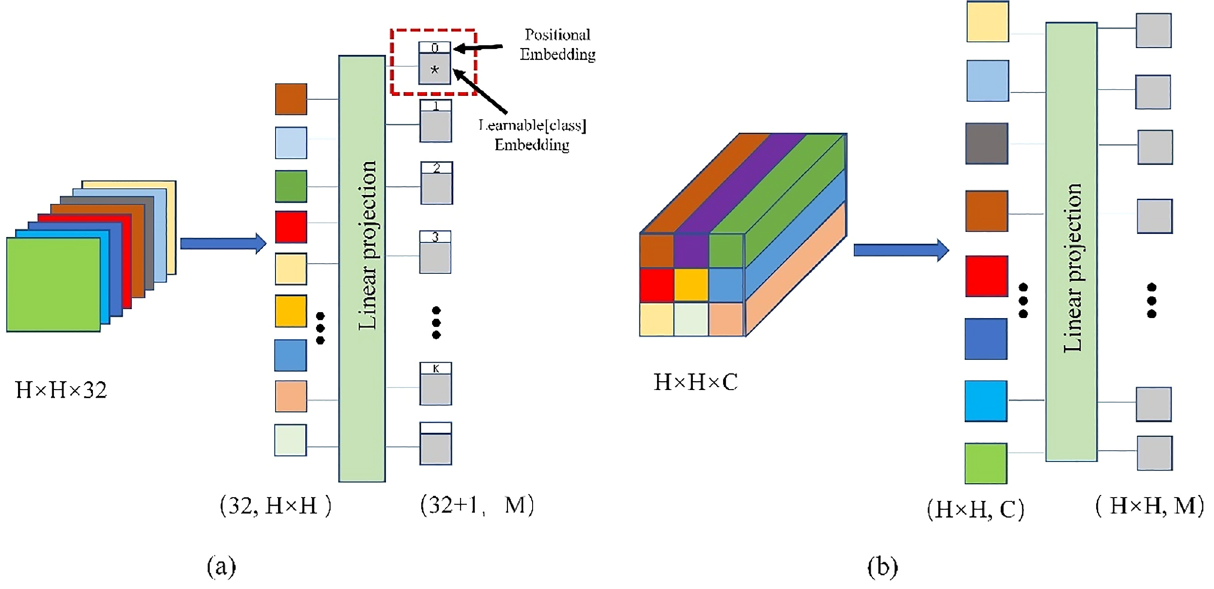
Figure 6. Two ways of linear projection methods. ( a ) Band-wise embedding ( b ) Pixel-wise embedding.